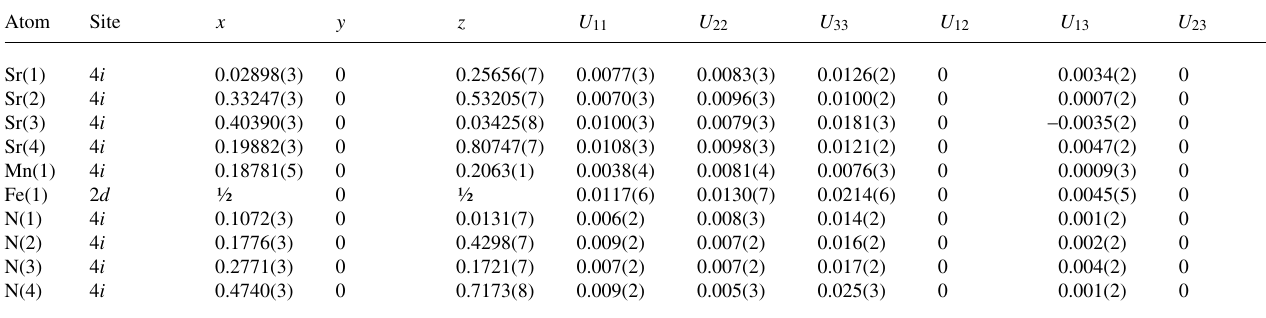
Table 2. Atomic coordinates and displacement parameters (in Å 2 )